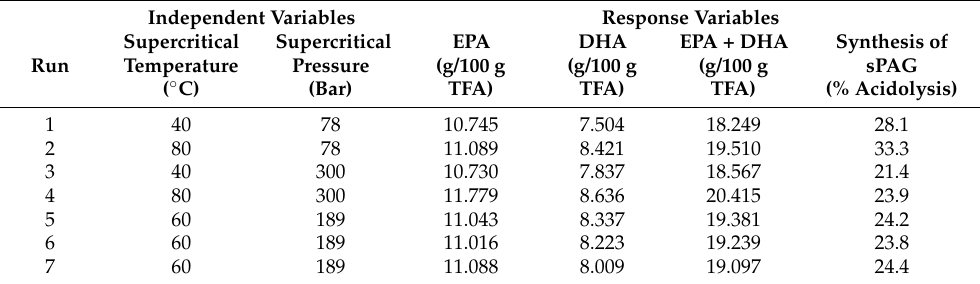
Table 1. 2 2 -screening factorial design (RSM) of two factors and seven experimental runs to optimize the synthesis of sPAG (% acidolysis), EPA, DHA, EPA + DHA content (g/100 g TFA) in the enzymatic acidolysis